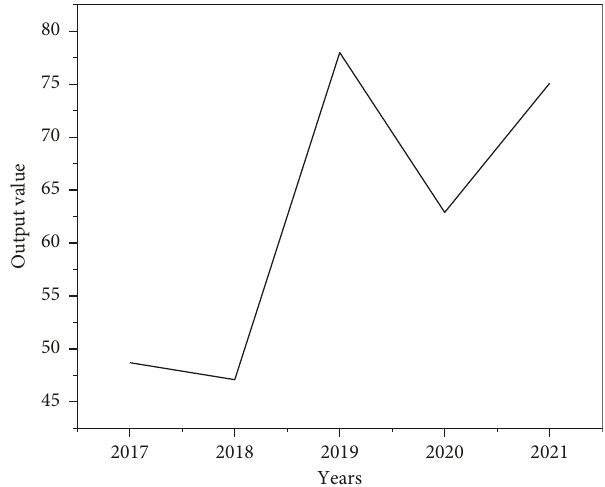
Figure 2: Gross output value of the construction industry.